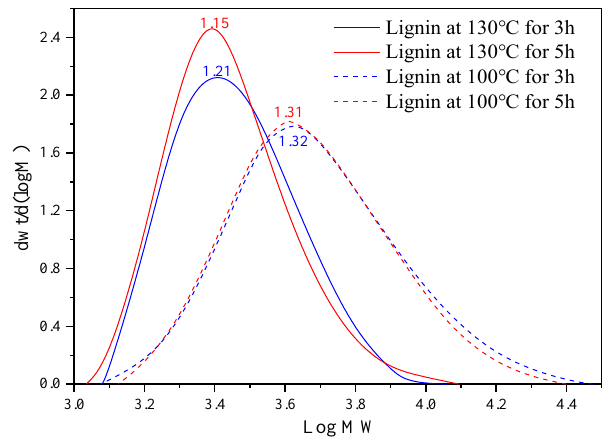
8.2 Figure 5. Ratio of condensed lignin in jute fibers pretreated at 100 and 130 °C. 3.2.3. Molecule-Weight Distribution Degradation and condensation of lignin in fibers pretreated for 3 and 5 h cause changes in the distribution of molecular weight, as shown in Figure 6. As seen from the figure, two distribution curves of lignin from the fibers at 100 °C highly overlap, whereas lignin in the fibers at 130 °C shows different polydispersity. At a temperature of 100 °C, only lignin with low molecular weight can be dissolved. After an initial stage of massive dissolution, the structure of residual lignin remains